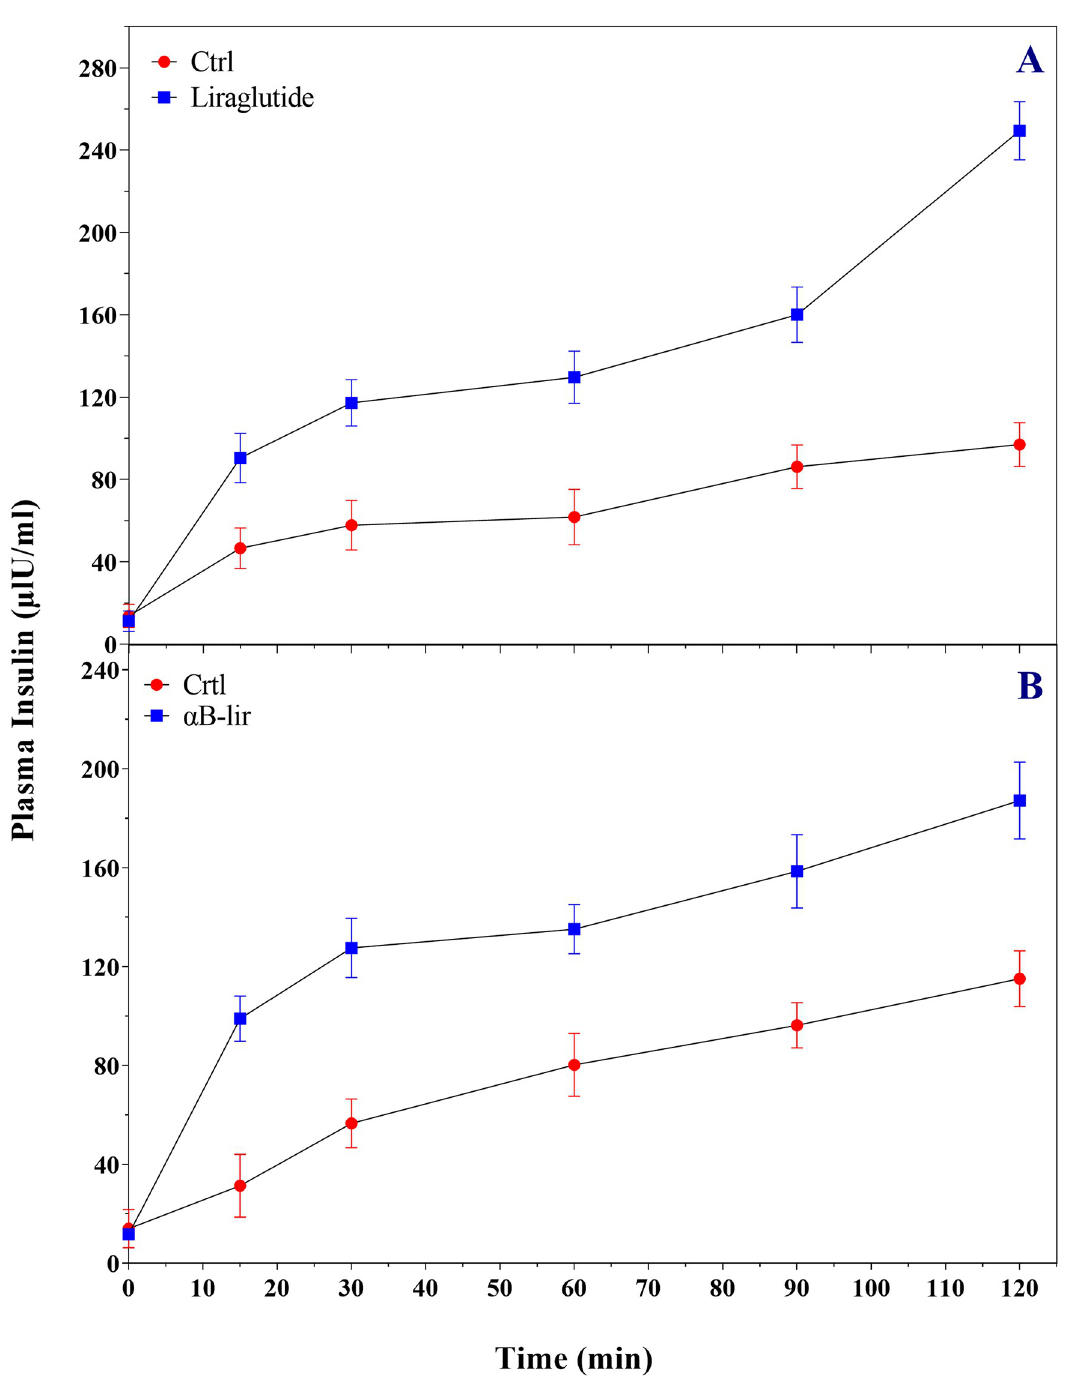
Fig 8. The analyses of the insulin induced secretion of LPP and α B-lir. The effect of LPP (200 μ g/kg body weight) ( A ) and α B-lir (1.4 mg/kg body weight) ( B ) on stimulation of the insulin secretion was studied by a single-dose injection. The plasma insulin levels of normal mice (n = 6) were measured by an appropriate insulin ELISA kit [51]. In the case of α B-lir, the plasma insulin level was monitored after the initial injection. The glucose concentration was 1.5 mg/g body weight of normal mice as injected at the time zero. All data were significantly different from the control group (p <